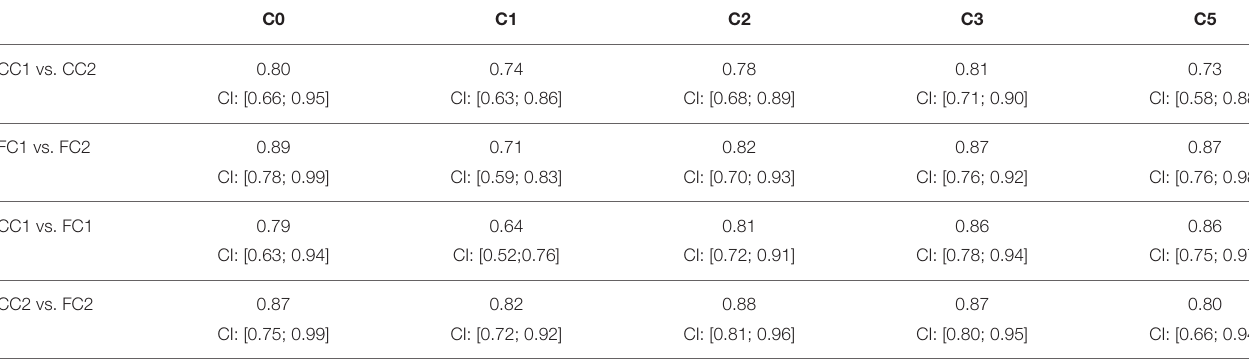
TABLE 5 | Intra- and inter-observer reproducibility of the different criteria. C0 C1 C2 C3 C5 0.78 0.81